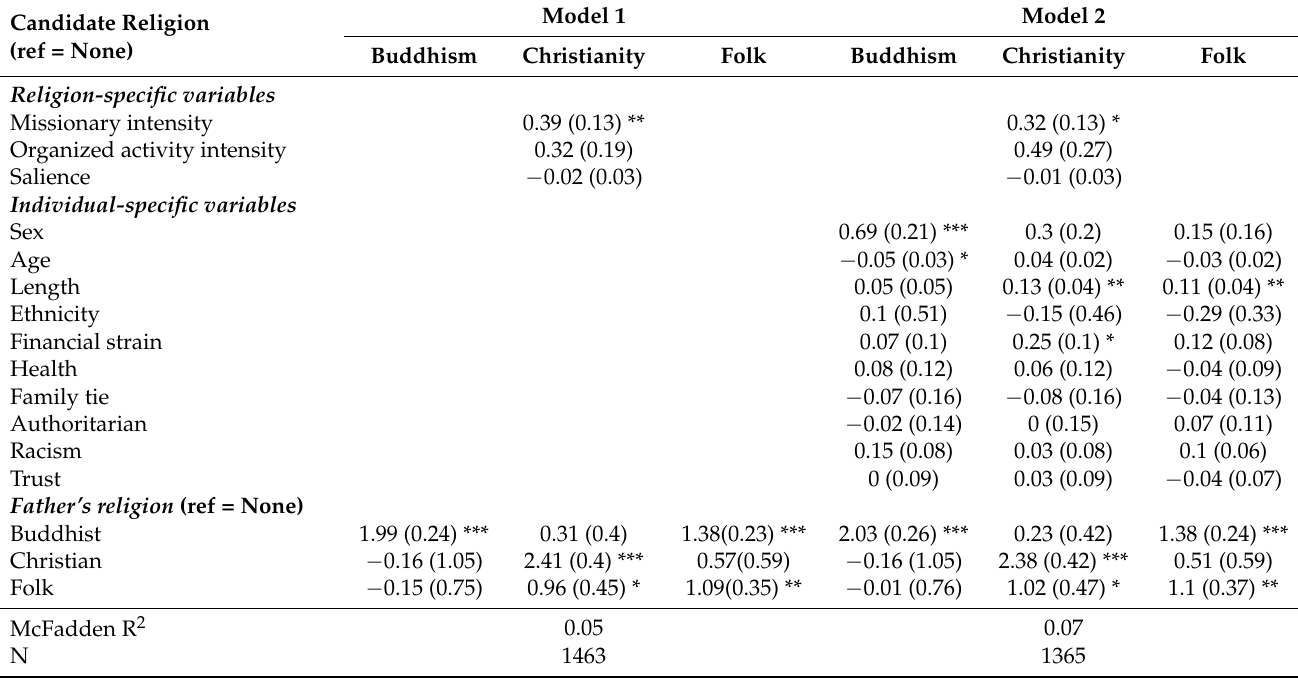
Table 4. Mixed logit model of intergenerational religious changes between father’s religion and child’s current religion.